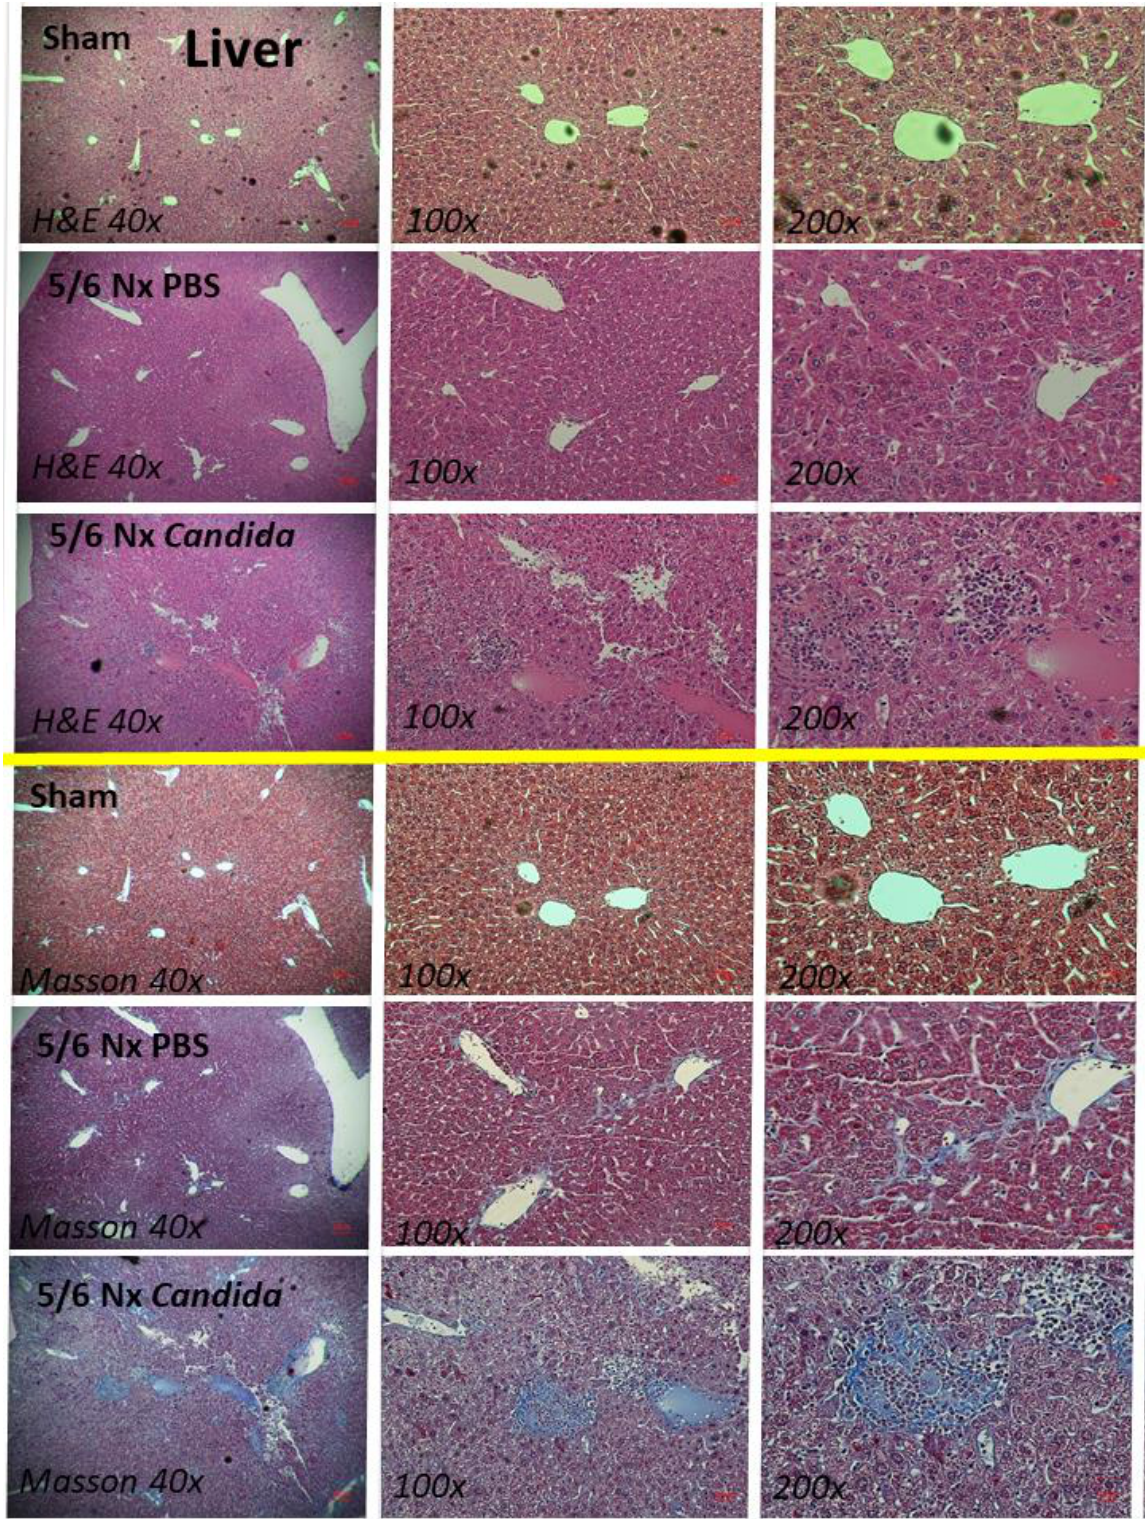
Figure 4. The representative liver histopathological pictures stained by hematoxylin and eosin (H&E) ( upper part ) or Masson’s trichrome color ( lower part ) (original magnification 40 – 200×) of Sham control, 5/6 nephrectomized mice with phosphate buffer solution (5/6 Nx PBS) or Candida administration (5/6 Nx Candida ) are demonstrated.